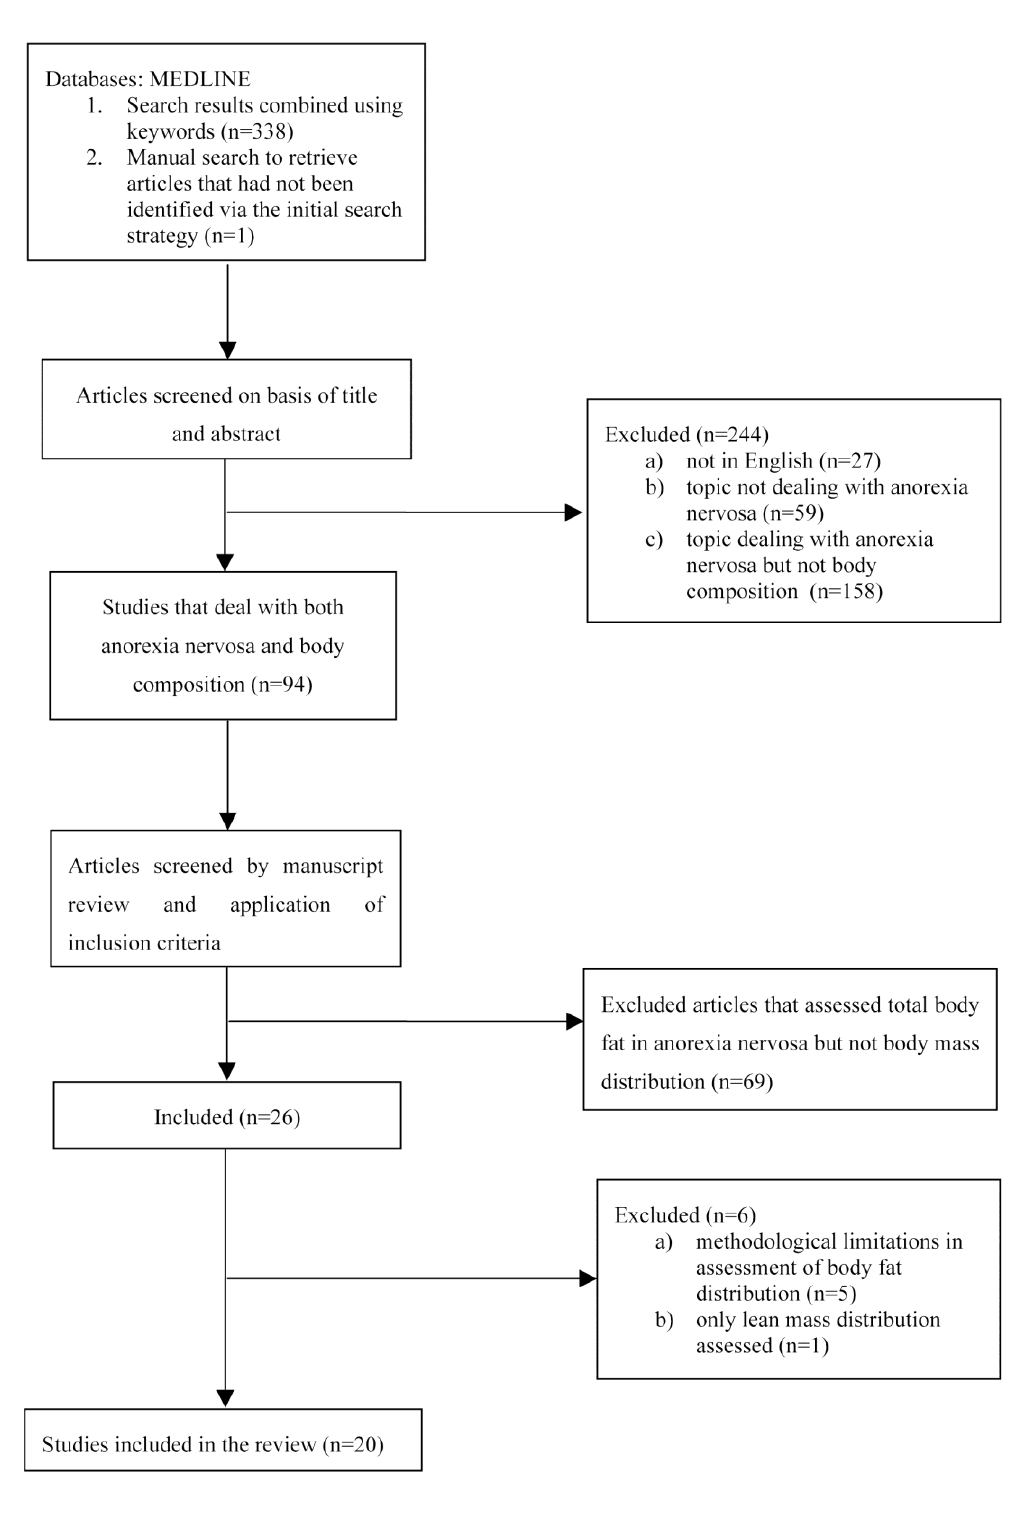
Figure 1. Flow chart summarizing the procedure for selecting